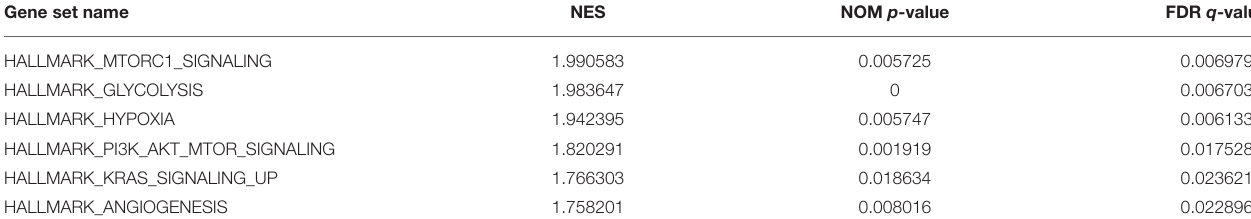
TABLE 3 | Gene sets enriched in the high PYGL expression phenotype.